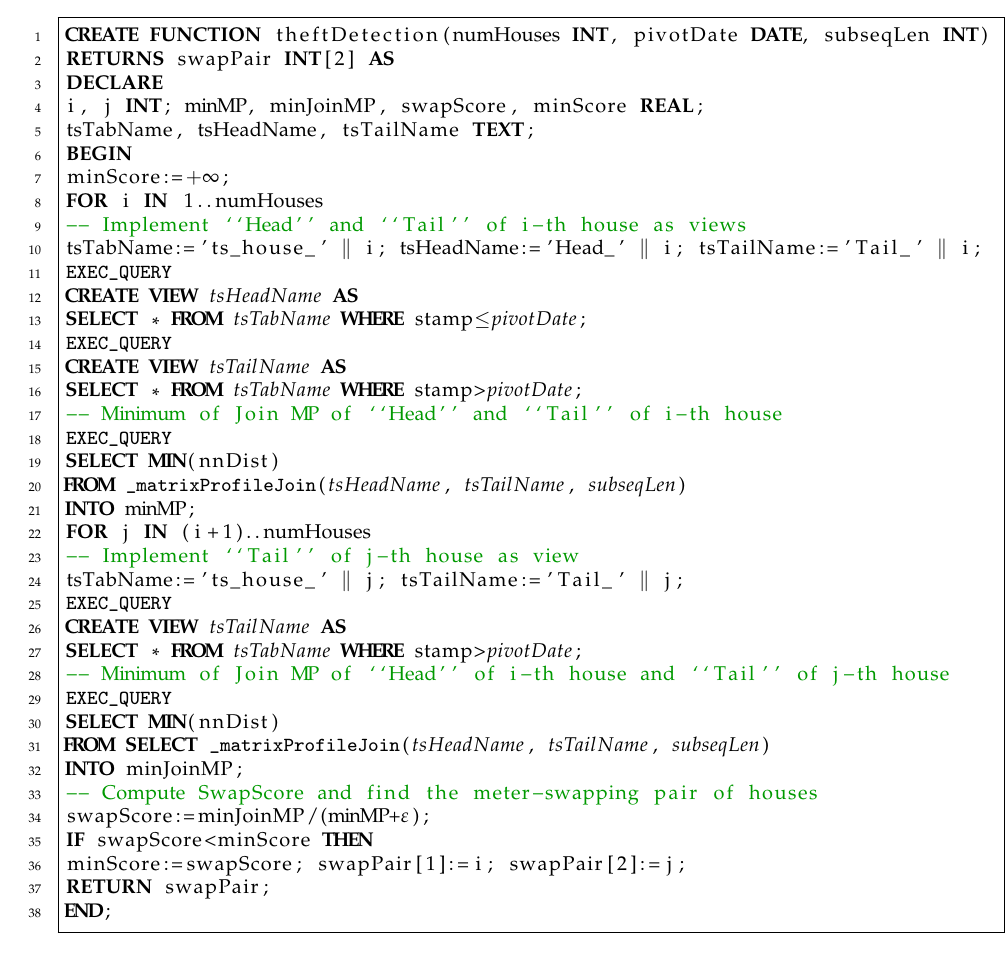
Figure 15. Implementation of the electricity theft detection case in